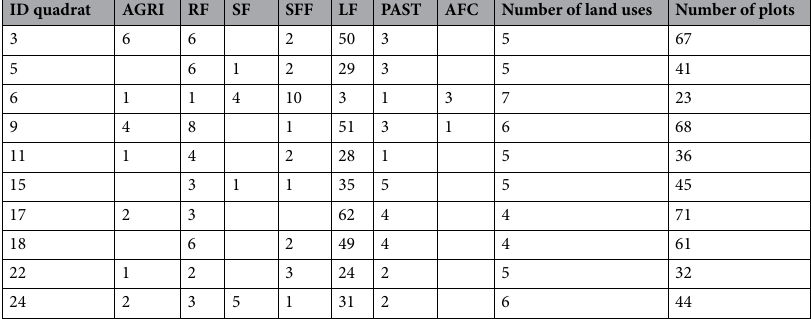
Table 3. Number of plots set up per quadrat in each land use. The different land uses are secondary forest (SF), secondary forest fragment (SFF), agroforestry coffee (AFC), agriculture (AGRI) and pastures (PAST), live fences (LF) and riparian forest (RF).